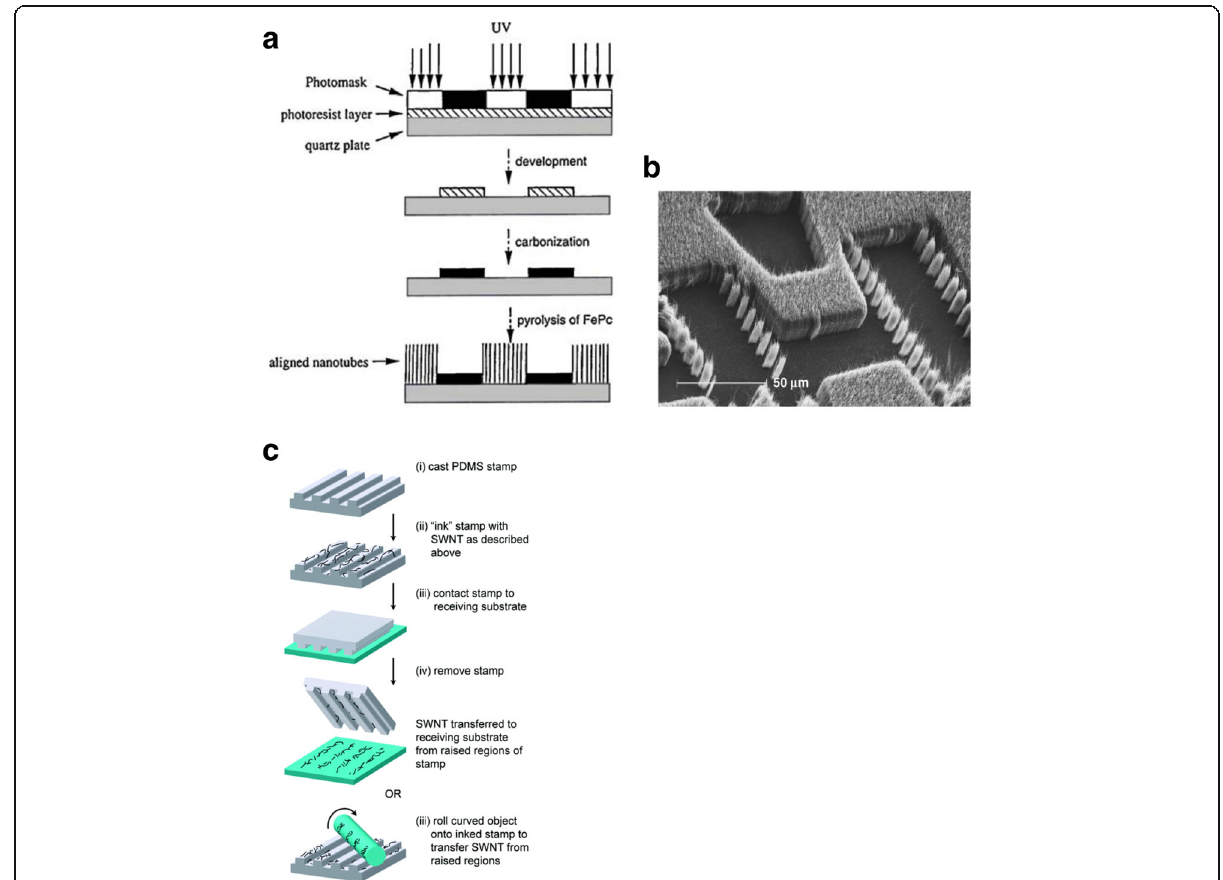
Fig. 39 a Schematic flow diagram of micropattern formation of vertically aligned MWCNT arrays by direct photolithography process. Adapted from [272]. b SEM images of patterned films of vertically aligned MWCNT arrays formed by the pyrolysis of FePc onto a photolithographically patterned quartz substrate. The resolution of the figure is in the micrometer scale. Adapted from [272]. c Step-by-step illustration of transfer printing of SWCNTs onto various substrates by contact stamping. Adapted from